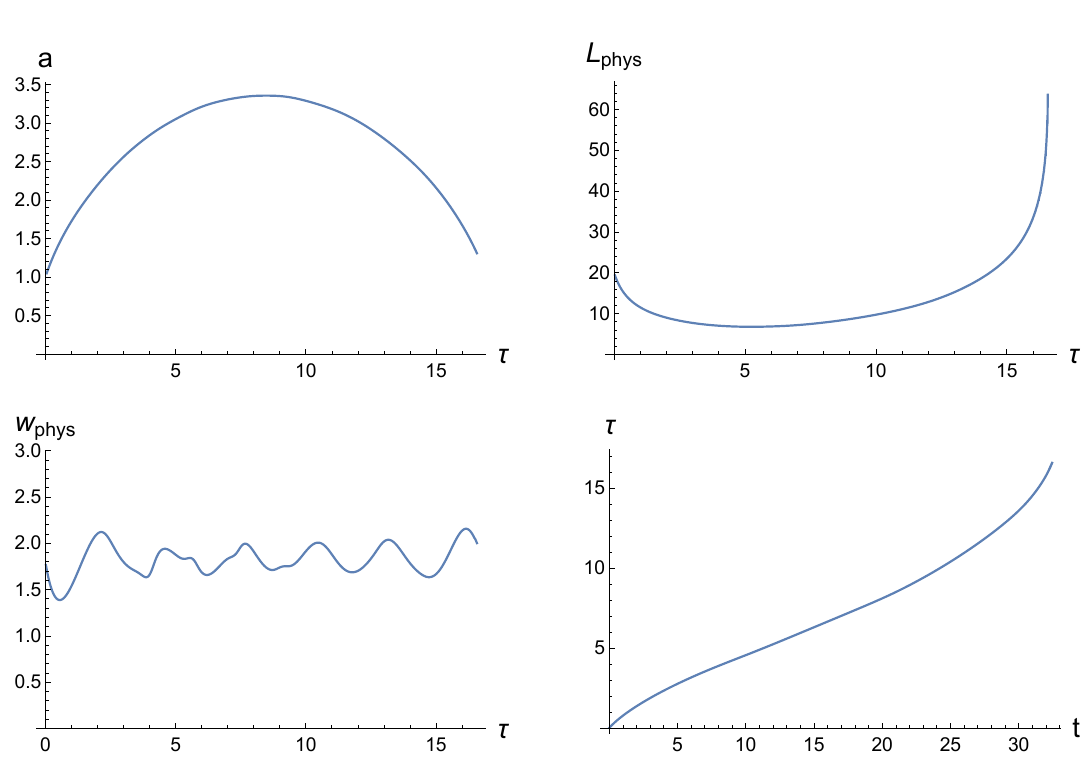
Figure 11 . The scale factor a , the physical size of the extra dimension L phys and the physical width of the domain wall w phys as functions of τ . The bottom-right plot shows the relation between t and τ . The parameters are chosen as (4.6) and V min = − 0 . 05